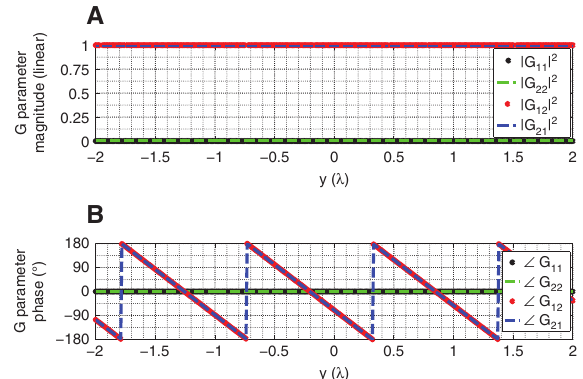
Figure 9: Close-up of a section of the top and bottom sides of the fabricated metasurface for reflectionless refraction at 20 GHz using a three-layer design. Inset: Example of an asymmetric three-layer unit cell used for the fabricated refracting